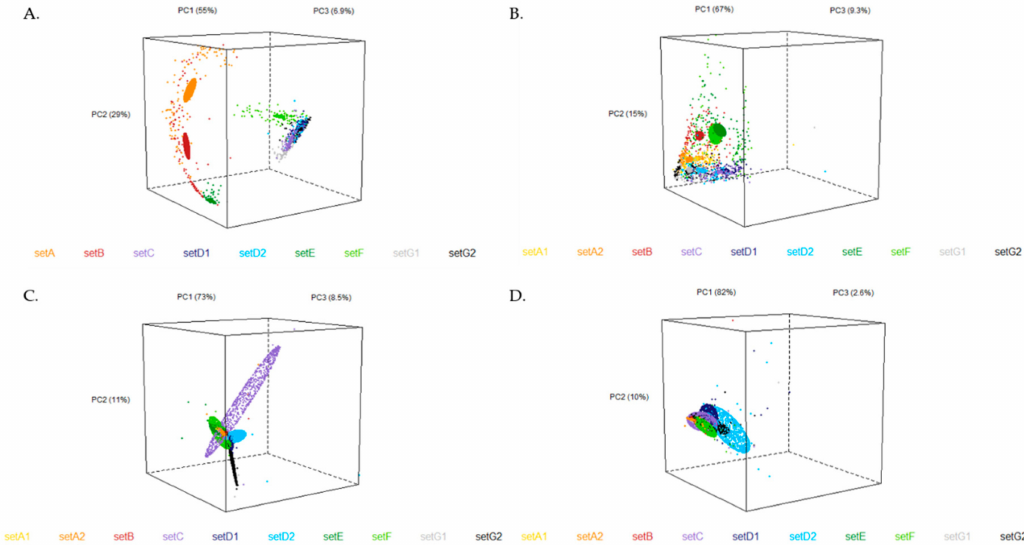
Figure 6. PCA score plots for ATR-FTIR ( A ). before and ( B ). after extraction and for Raman ( C ). before and ( D ). after